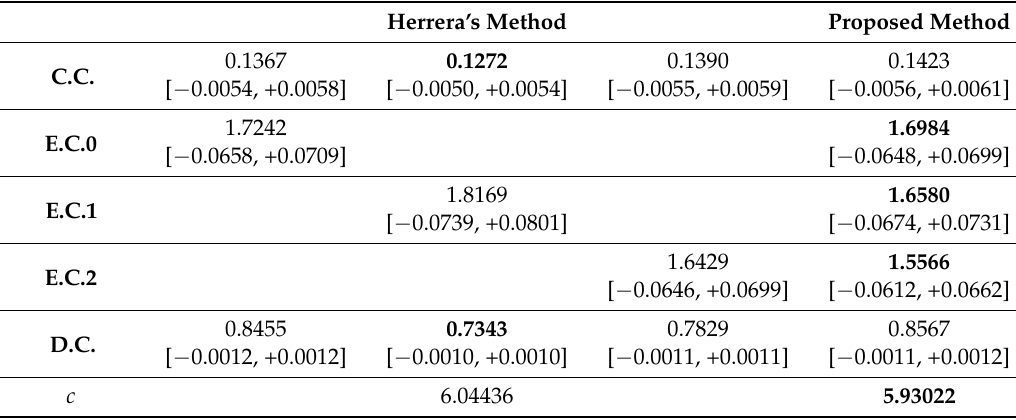
Table 4. Standard deviation of re-projection